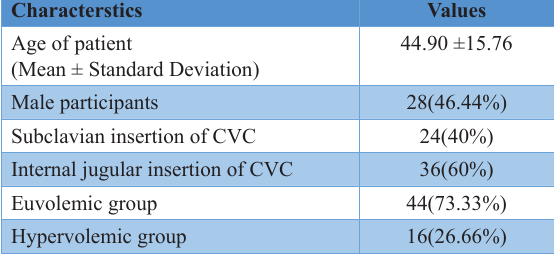
Table 1. Demography of the patients